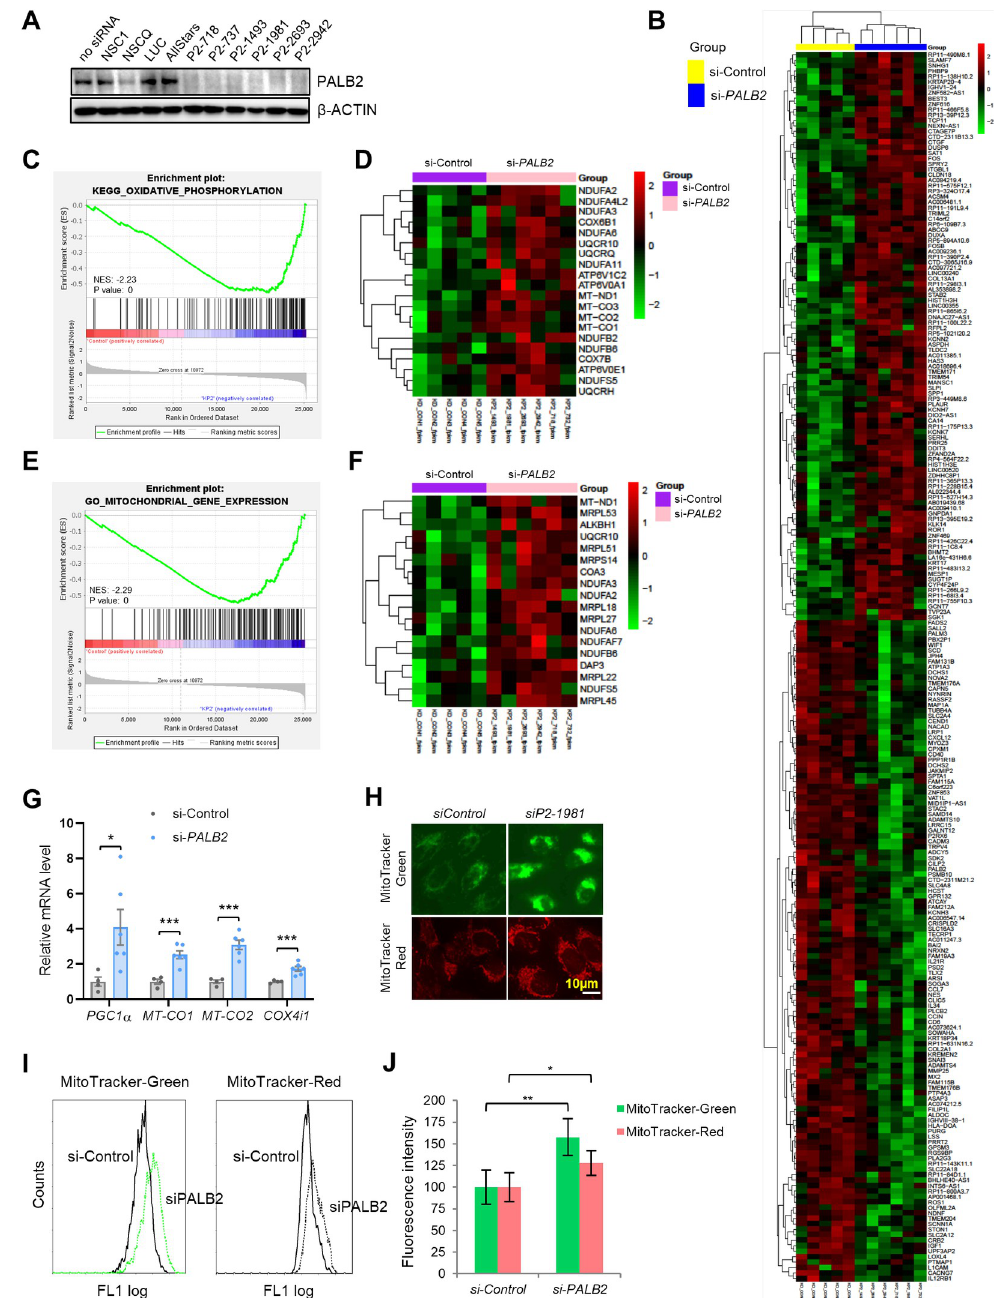
Fig 4. Impact of PLAB2 loss on mitochondrial gene expression and function in human medulloblastoma cells. (A) Western blot analysis of PALB2 levels in DAOY cells treated with transfection reagent alone, 4 different control siRNAs and 6 different PALB2 siRNAs. β -ACTIN was used as loading control. (B) Heat map showing top 50 upregulated and top 50 downregulated genes from two-way hierarchical clustering analysis of the 11 samples (5 control and 6 si PALB2 ). (C and D) GSEA enrichment plot (C) and heat map (D) of the expression of genes in the “oxidative phosphorylation” gene set in control and PALB2 knockdown cells. (E and F) GSEA enrichment plot (E) and heat map (F) of the expression of genes in the “mitochondrial gene expression” gene set in control and PALB2 knockdown cells. (G) qRT–PCR analysis of the expression of PGC1 α , MT-CO1 , MT-CO2 and COX4i1 in control and PALB2 knockdown cells. Results are averages of the 5 control and 6 PALB2 knockdown cells from three independent experiments, each performed in two technical replicates. (H) Representative fluorescence images of MitoTracker Green and MitoTracker Red from control and PALB2 knockdown cells. Scale bar = 10 μ m. (I and J) Representative flow cytometry overlay plot (I) and quantified fluorescence intensity (J) of